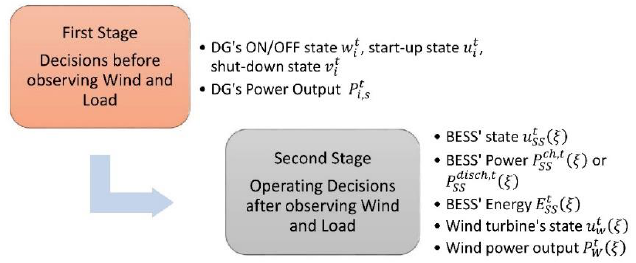
Figure 3. The two-stage optimization model.